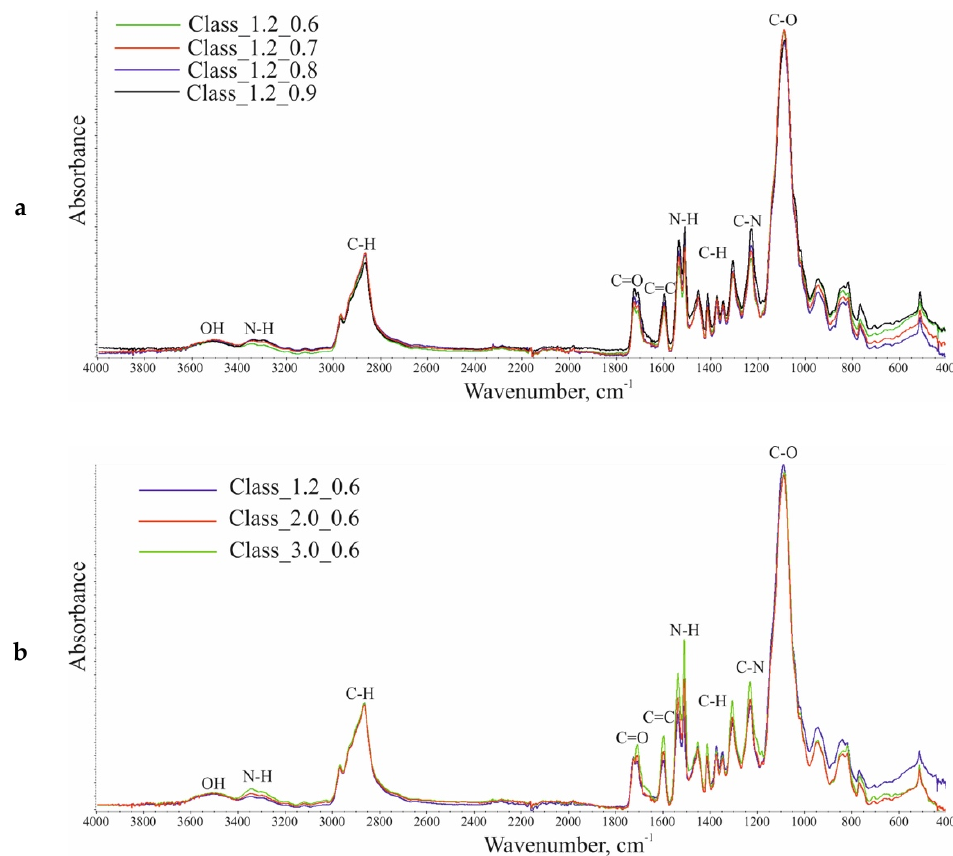
Figure 4. Comparison of ATR-FTIR (attenuated total reflection, Fourier transform infrared spectroscopy) spectra for: ( a ) foams with different I NCO levels at 1.2 php of water and ( b ) foams with different water contents at I NCO = 0.6.